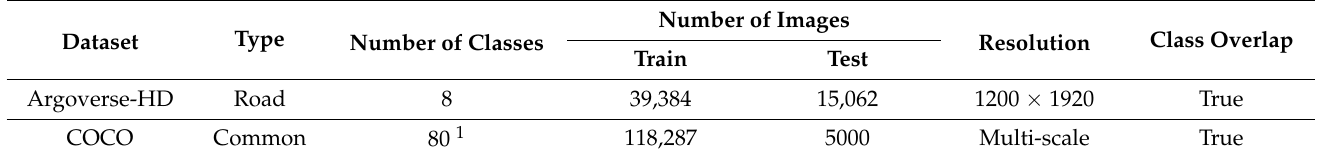
Table 1. Statistics of the two datasets utilized in training and testing the proposed object